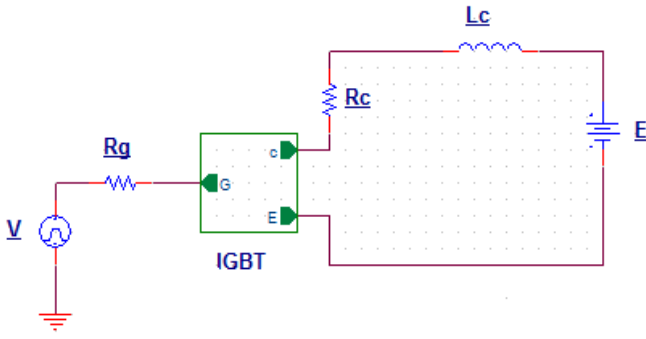
Figure 20. The switching circuit of an IGBT module . Figure 21 represent the temperature variation as a function of time with and without a cooling system.